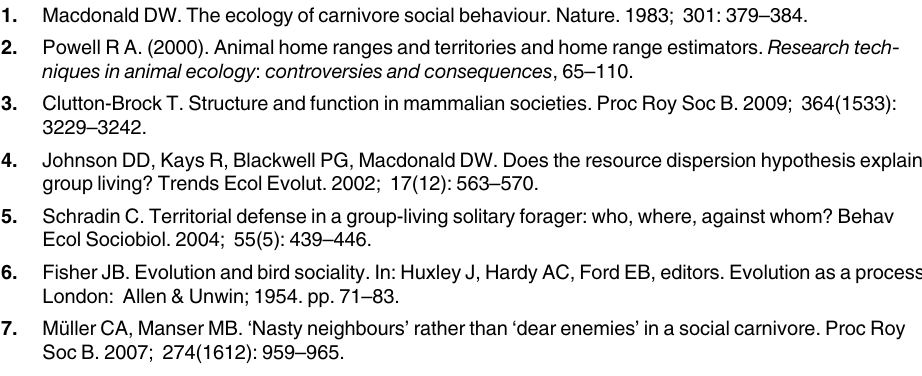
S4 Table. Statistical summary of the models linking subcaudal over-marking responses to a global model. The global model included the variables; ‘ age ’ of the donor and responder (lev- els: yearling, adult); ‘ sex ’ of the donor and the responder (levels: male, female); ‘ reproductive status of the female ’ donor and responder (levels: oestrous, non-oestrous); and ‘ reproductive status of the male ’ donor and responder (levels: descended, fully descended), as well as interac- tion terms, as factors in these models. Responder and trial ID were included as random effects in these models. This table is the basis of the model averaging, for which results are presented in Table 4 of the main text. The support for each model, based on Akaike criterion, is presented in the first three columns. The fourth column presents the degrees of freedom associated with each model. Subsequent columns present coefficient estimates of the parameters included in each model. S5 Table. Raw data on which all analyses are